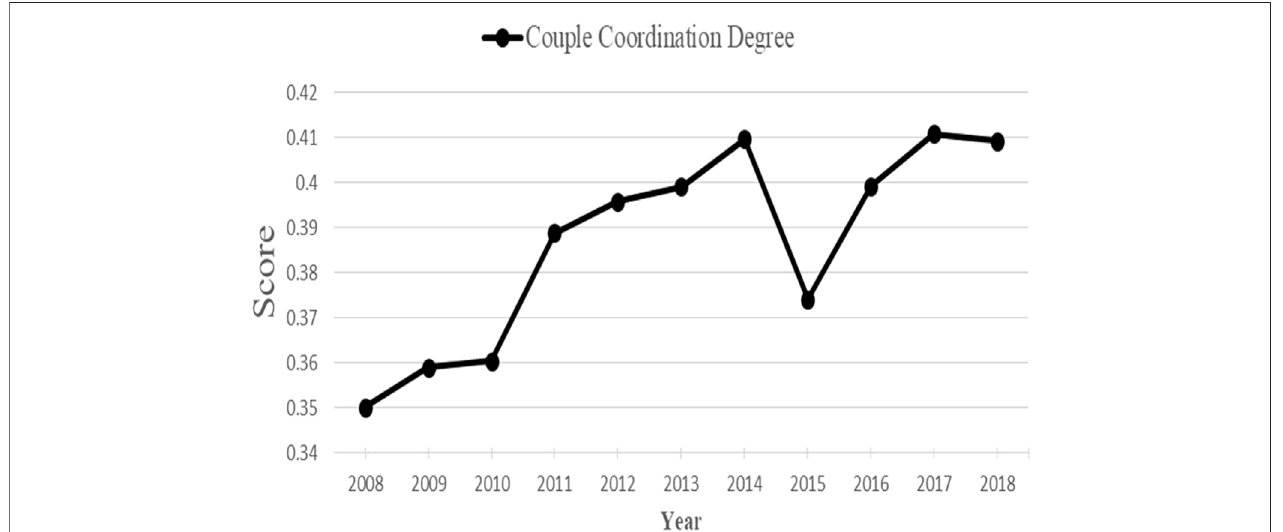
FIGURE 4 | Time trend of the average coupling coordination degree of cities in the Yangtze River Delta from 2008 to 2018.